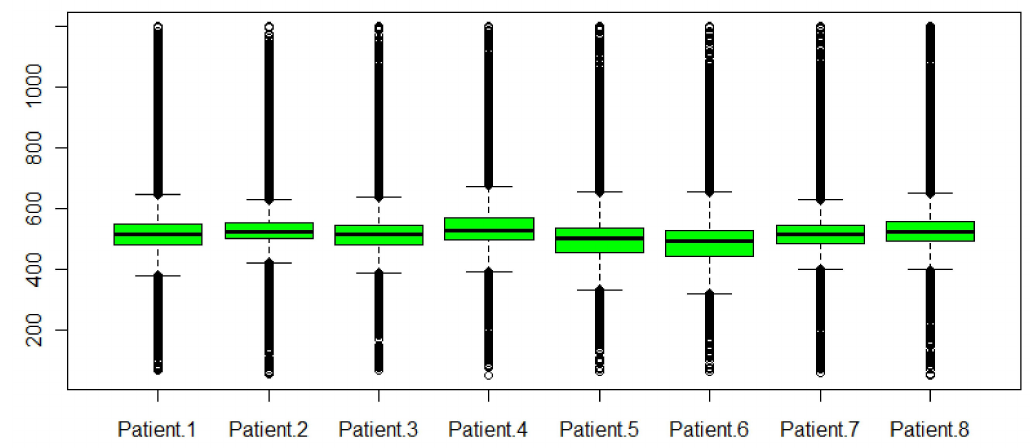
Figure 4: Box diagram of the lengths of the fragmented segments.